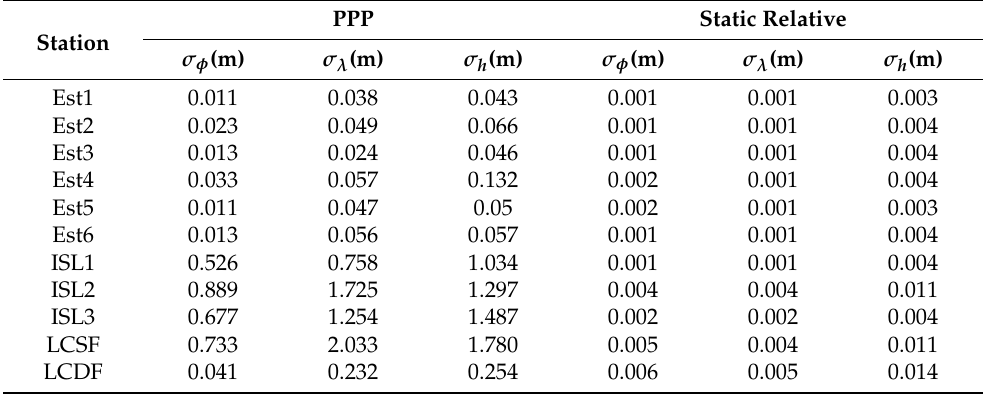
Figure 11. Differences in the CEP and EPV of the static relative method according to the INEGI technical standard. ( a ) EPV with inclusion of geoidal model GGM10; ( b ) EPV without inclusions of geoidal model GGM10. Table 8. Standard deviations obtained with PPP in CSRS-PPP and the static relative